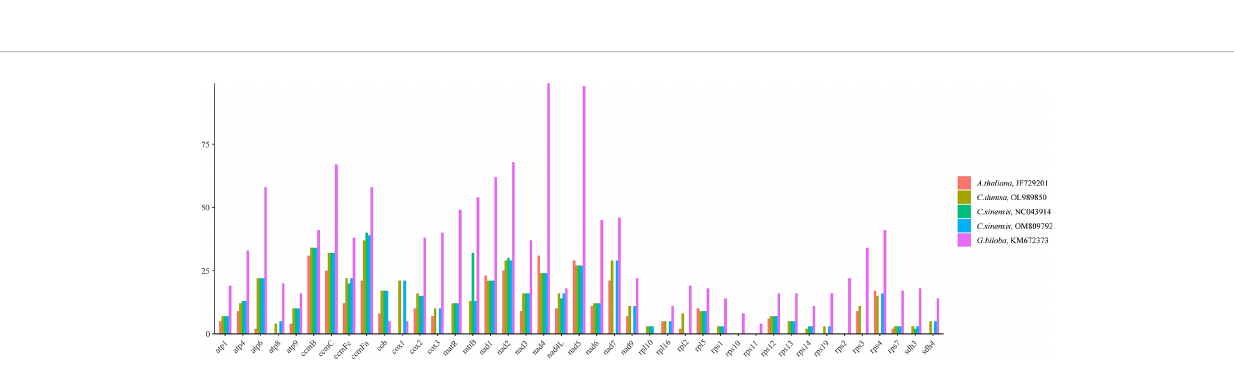
FIGURE 7 The distribution of RNA editing sites across the PCGs of the mitochondrial genomes of fi ve different angiosperms.